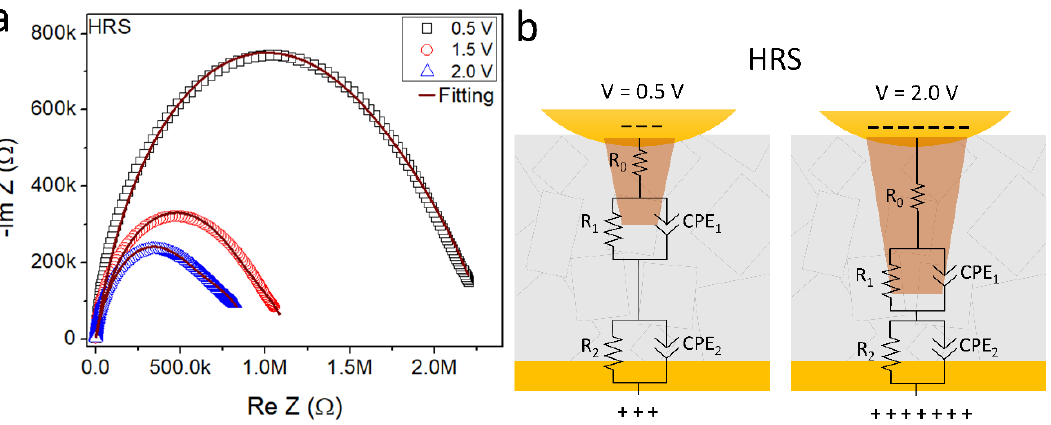
Figure 6. ( a ) Nyquist diagrams of PW/Au sample in HRS (off state) at 0.5, 1.5, and 2.0 V DC bias. ( b ) The corresponding equivalent circuit and schematic diagram of the main interfaces and transport mechanisms.